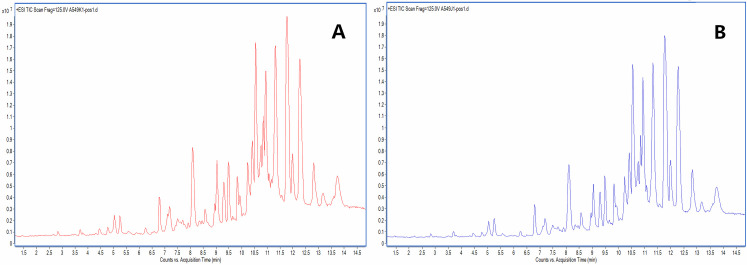
Total ion chromatograms of A549 cells.(A, tumor group, B, dose group).